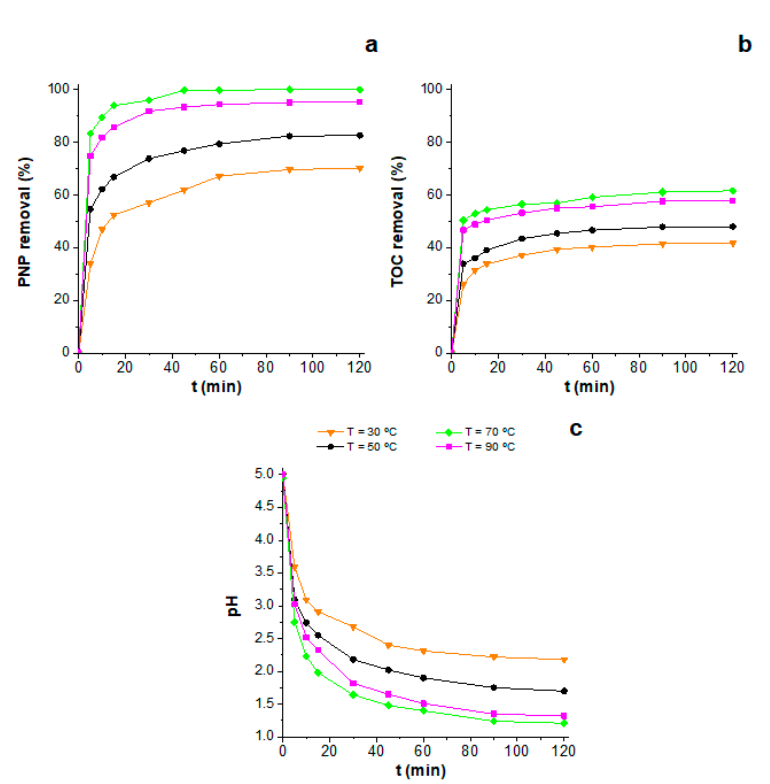
Figure 2. Influence of temperature on PNP ( a ) and TOC ( b ) removals and pH evolution ( c ) during the persulphate activated by radiation process ([PNP] o = 500 mg/L, pH = 5.0, [S 2 O 82 − ] o = 6.4 g/L and I = 500 W/m 2 ).